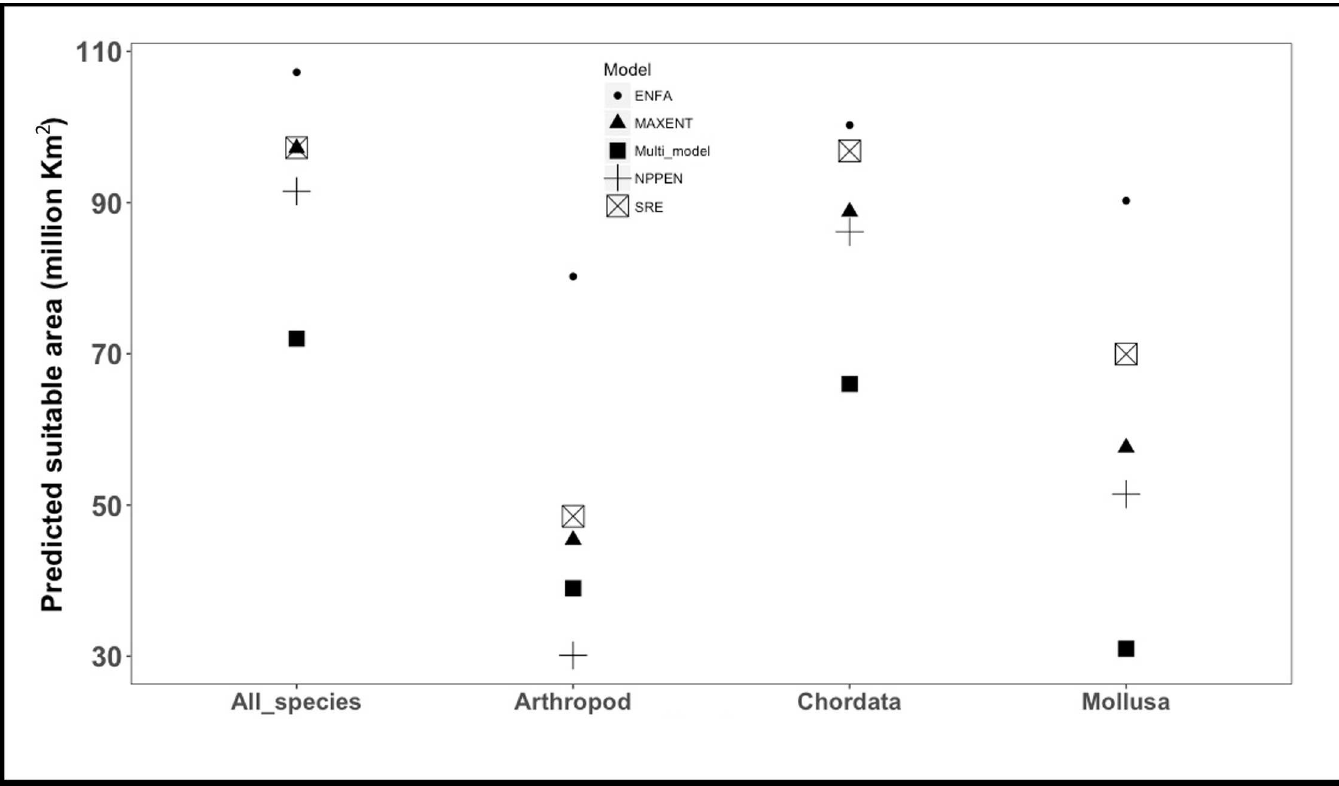
Fig 6. Predicted marine area suitable for mariculture from four species distribution models: ENFA, MAXENT, NPPEN and SRE; and weighted Multi-model. ENFA predicted the highest area with 107 million km 2 while the Multi-model predicted 72 million km 2 .